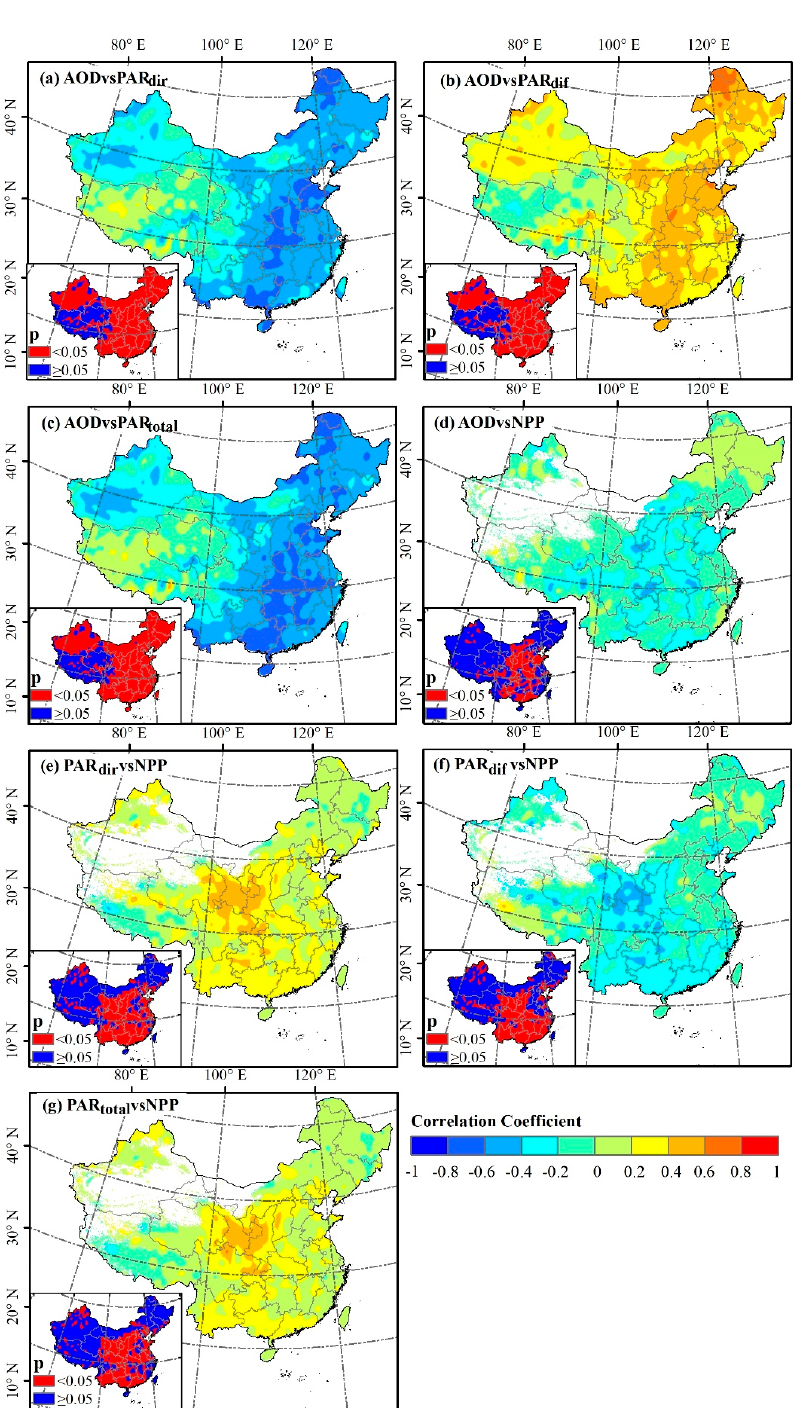
Figure 6. The correlation coefficient (R) map between ( a ) AOD and PAR dir ( b ) AOD and PAR dif ( c ) AOD and PAR total ( d ) AOD and NPP ( e ) PAR dir and NPP ( f ) PAR dif and NPP ( g ) PAR total and NPP and their corresponding p-value maps.